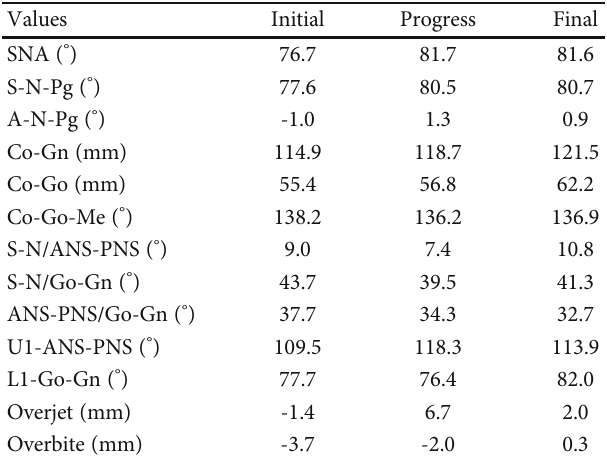
Figure 14: Case no. 2 facial photos, intraoral photos, and lateral cephalogram at T Table 2: Cephalometric values of case no. 2 before treatment, after PS3 treatment, and at the end of fi xed appliance